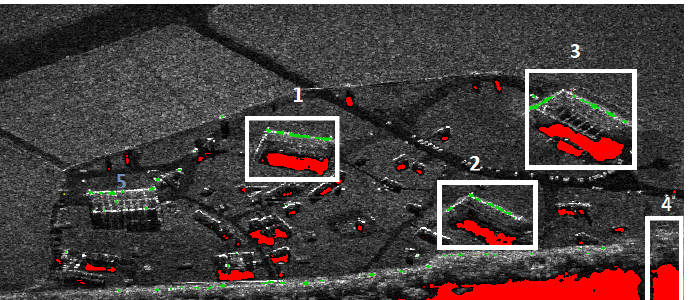
Figure 3. Extracted parts of the image of an urban area.